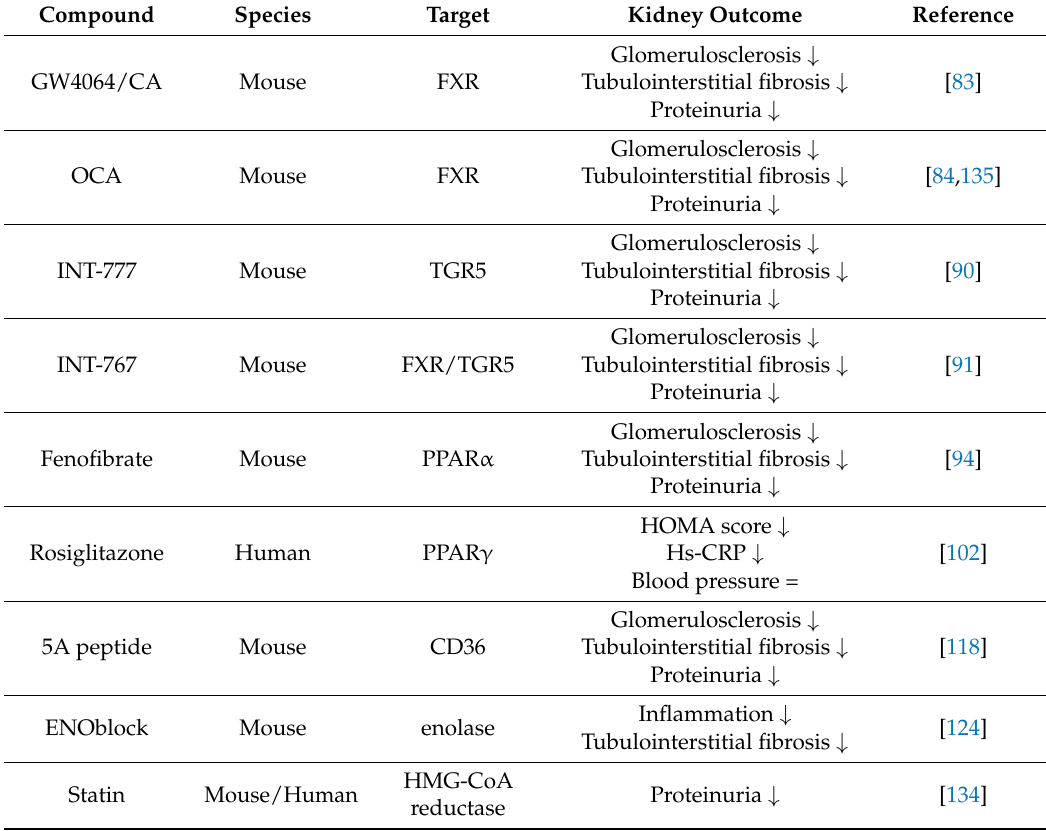
Table 1. Main preclinical/clinical studies on the effect of lipid-lowering drugs on kidney function.